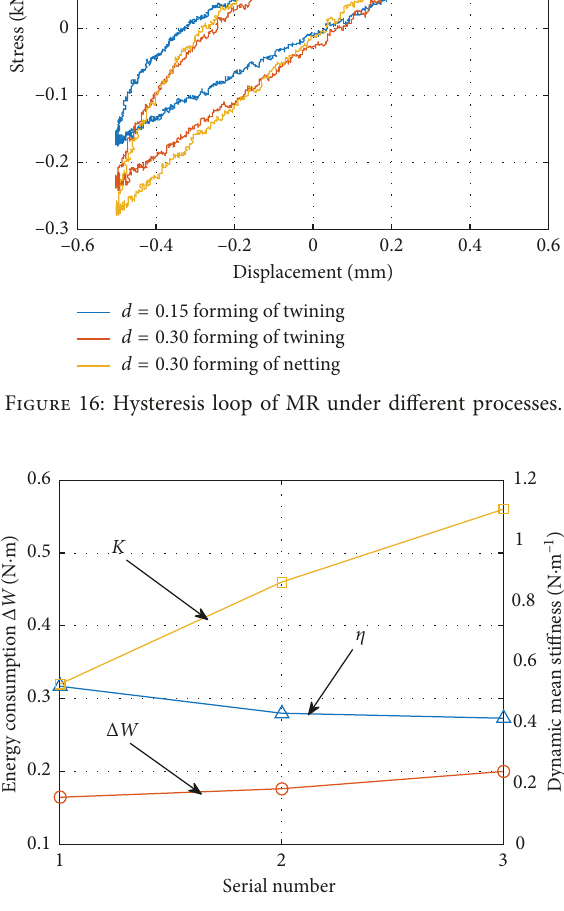
Figure 17: Parameter variation curves under different processes. η is the dissipation